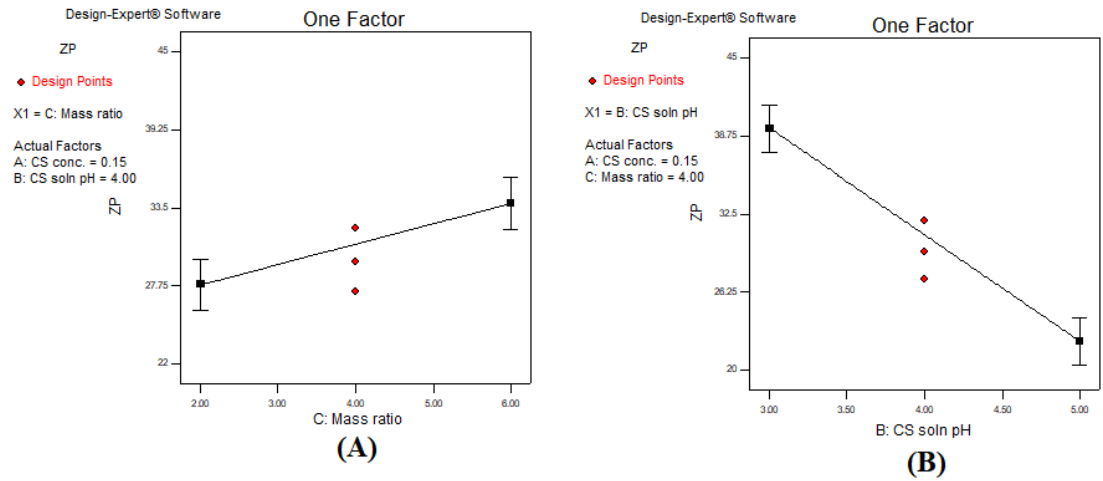
Figure 5. One factor line plot of the main effect of ( A ) CS: TPP mass ratio, and ( B ) CS solution pH on the ZP.